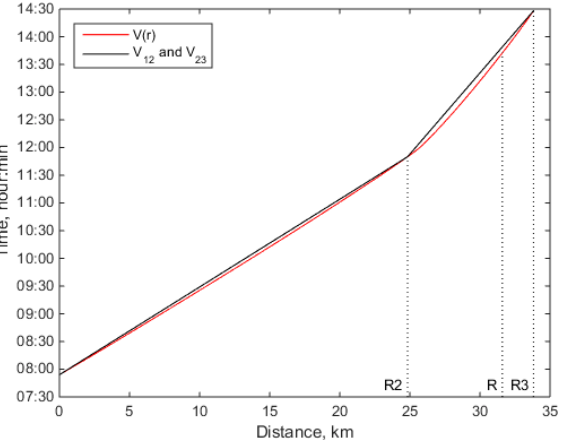
Figure 8. Time as a function of the soliton’s position for different models of its speed.